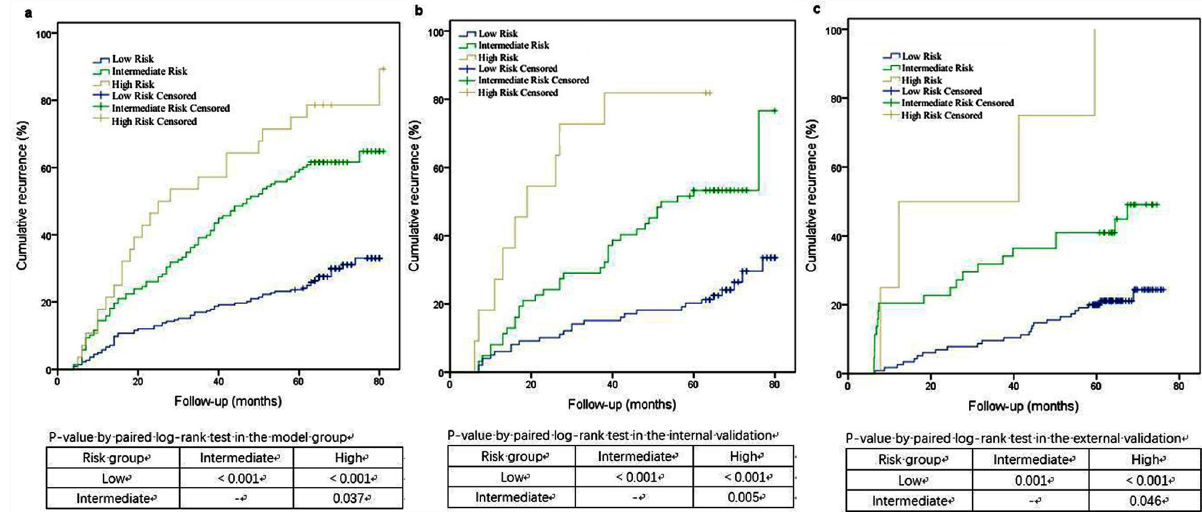
Fig 1. PI-based Kaplan–Meier analysis in (a) model group, (b) internal validation, and (c) external validation.